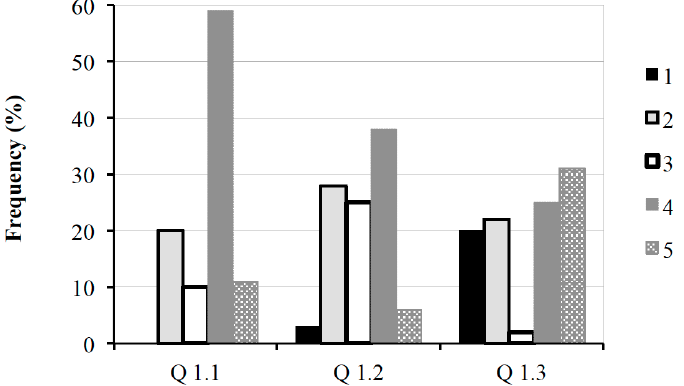
Fig. 1. Students’ responses to the questions of Section 1 in Questionnaire A presented on a five-point Likert scale, where 1 is the least value